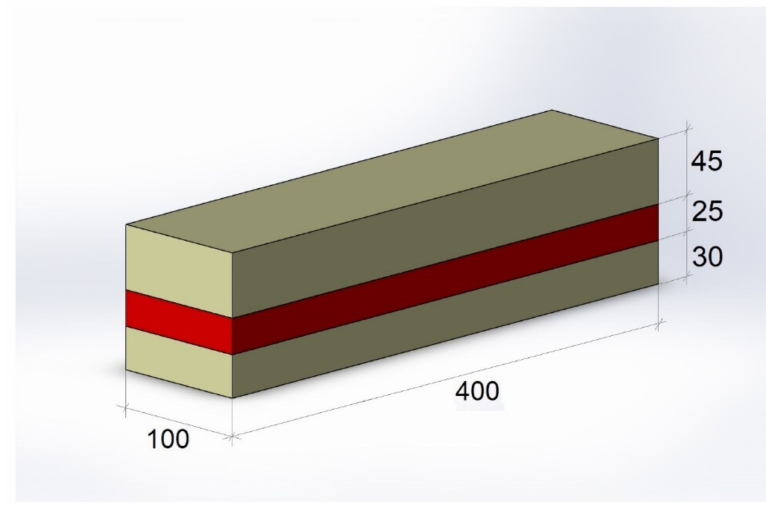
Figure 6. Fiber distribution in the prism of Group A3.